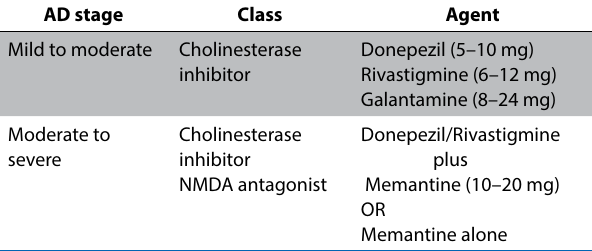
Table IV. Approved AD therapies 83